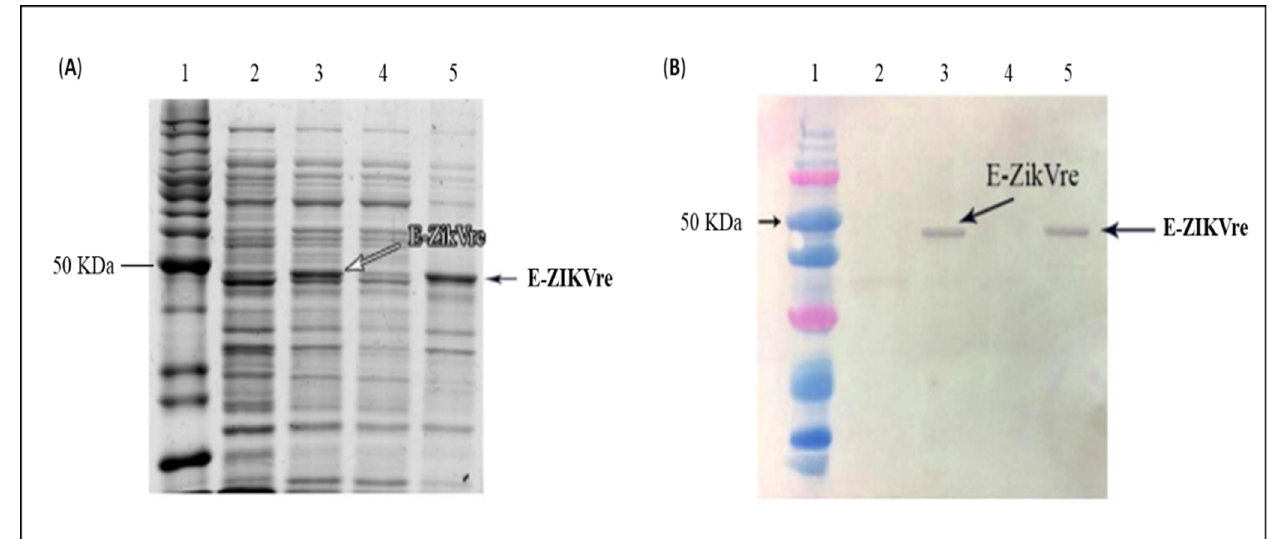
Figure 3. Evaluation of E-ZIKVre expression and solubility analysis in E. coli SHuffle . ( A ) SDS-PAGE gel. Line 1—benchmark; line 2—non-induced culture; line 3—induced culture; line 4—soluble fraction; line 5—insoluble fraction. ( B ) Immunoblot assay. Line 1—dual color; line 2—non-induced culture; line 3—induced culture; line 4—soluble fraction; line 5—insoluble fraction. Primary antibody: Anti-His.